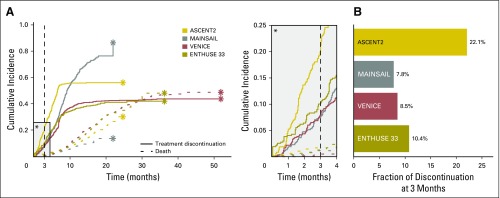
Rate and frequency of treatment discontinuation across trials. (A) Trial-specific cumulative incidence functions for treatment discontinuation as a result of adverse events or possible adverse events (solid lines) and death (dotted lines). (B) Fraction of patients with metastatic castration-resistant prostate cancer who discontinued treatment ≤ 3 months after initiation because of adverse events or possible adverse events.